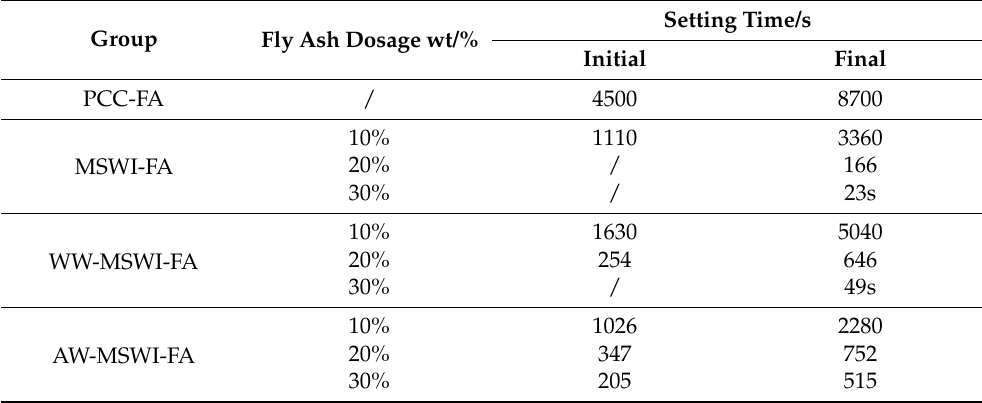
Table 6. Effect of fly ashes on setting time of AACMs. Group Fly Ash Dosage